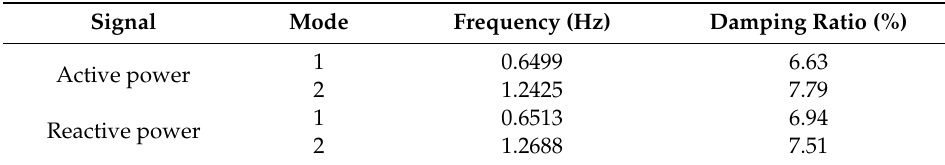
Table 4. Oscillation parameters of AC power.